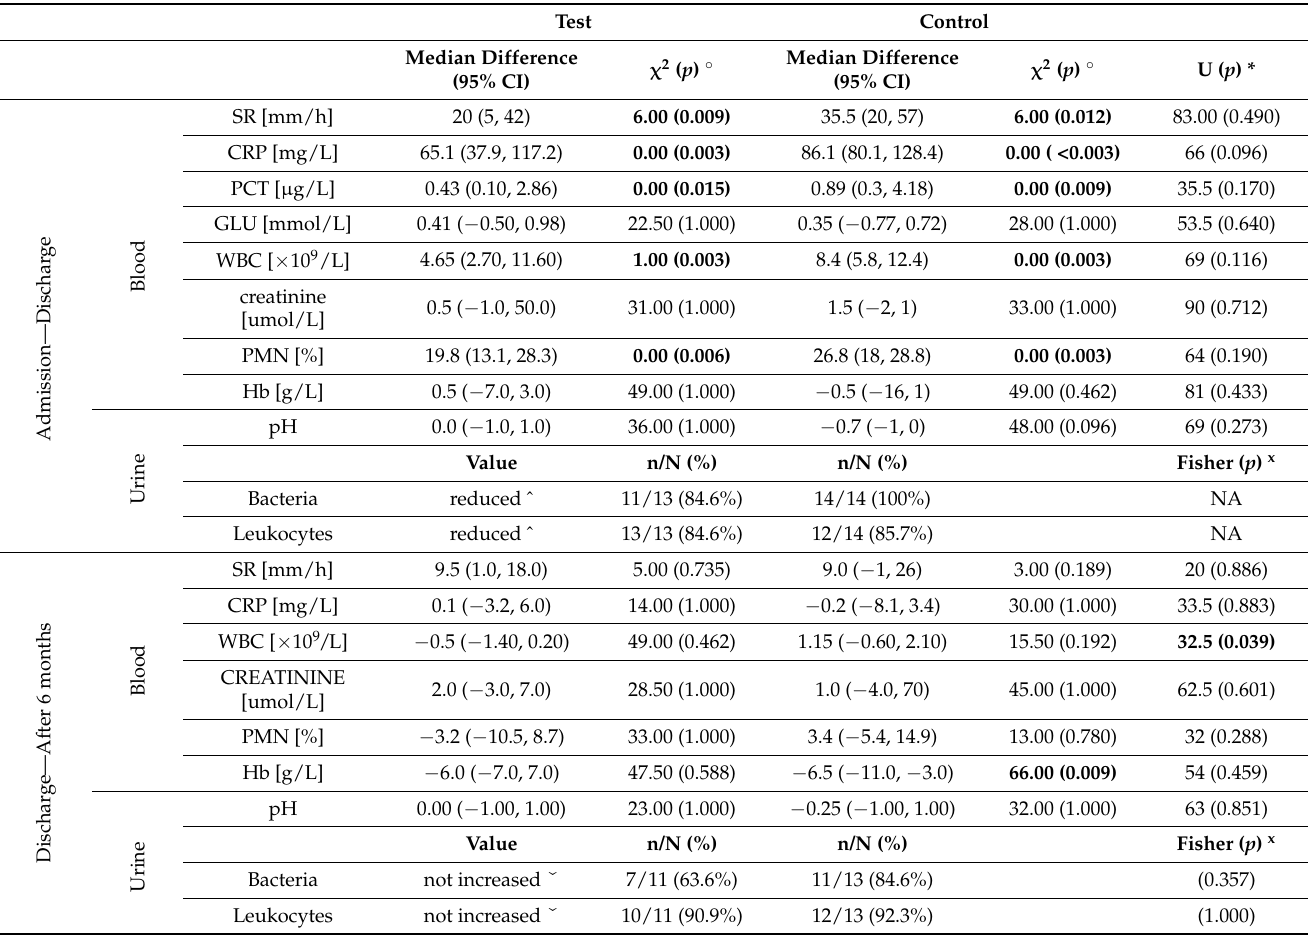
Table 2. Comparison of the basic blood and urine parameters measured at admission, on discharge and after six